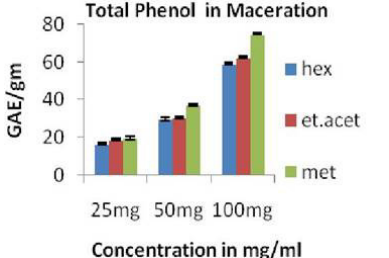
Fig. 1. Total steroid content in maceration